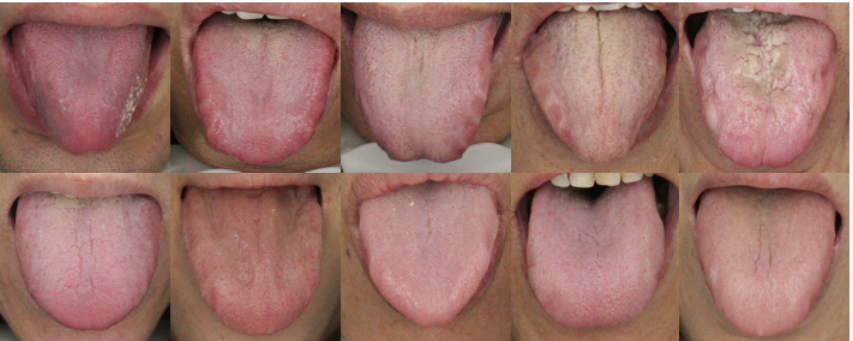
Figure 11. Tongue images in the closed environment.